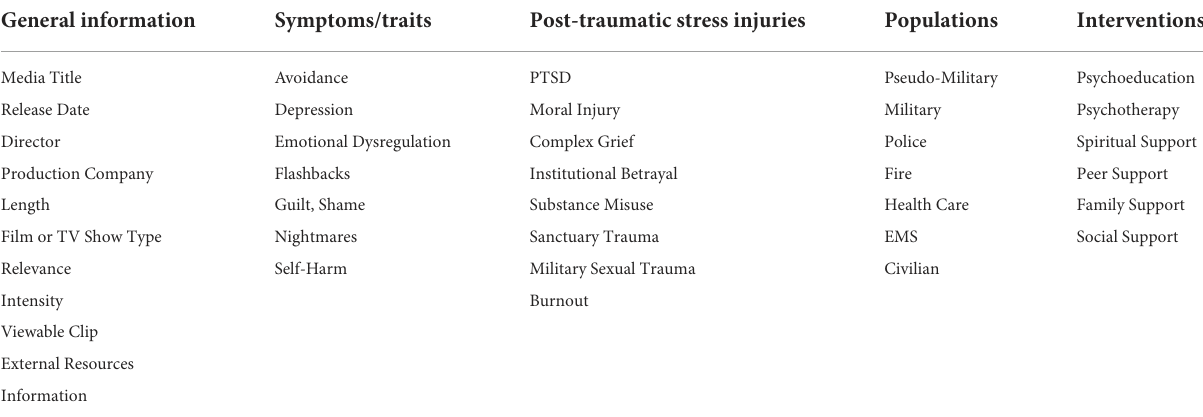
TABLE 1 Dataset